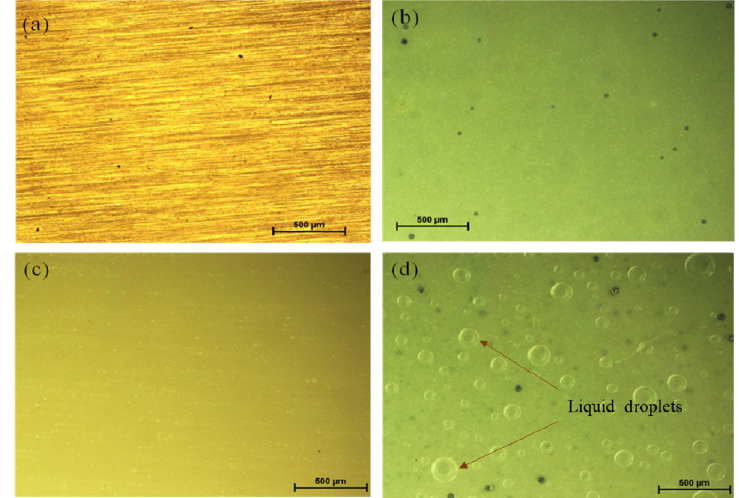
Fig. 1 Optical microscope images of the composite surface: (a) SU-8, (b) BN, (c) BNSN, and (d) BNFY.